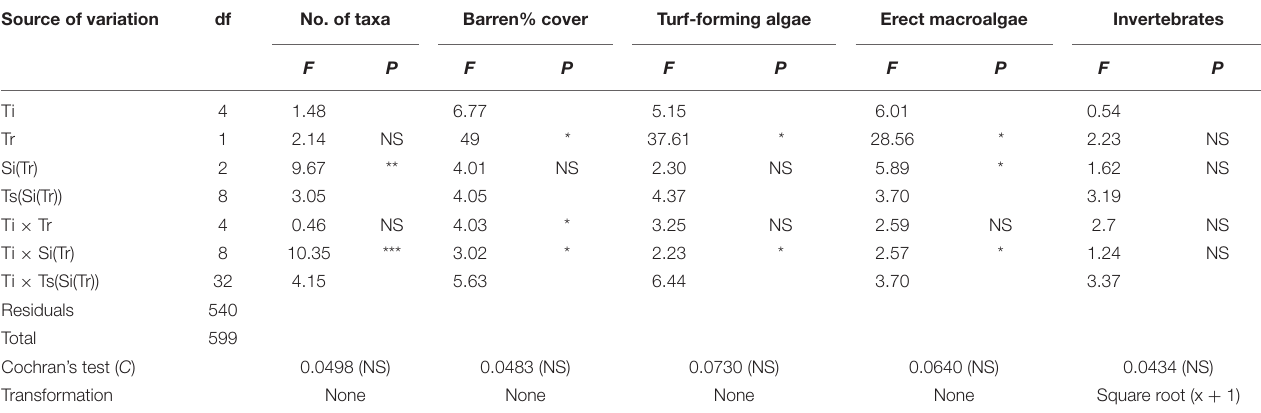
TABLE 2 | Summary of ANOVA testing the effect of sea urchin culling on species richness (no. of taxa), percentage cover of bare rock, and the three main categories characterizing the surveyed assemblages (i.e., turf-forming algae, erect algae, and invertebrates) across time. Source of variation df No. of taxa Barren%